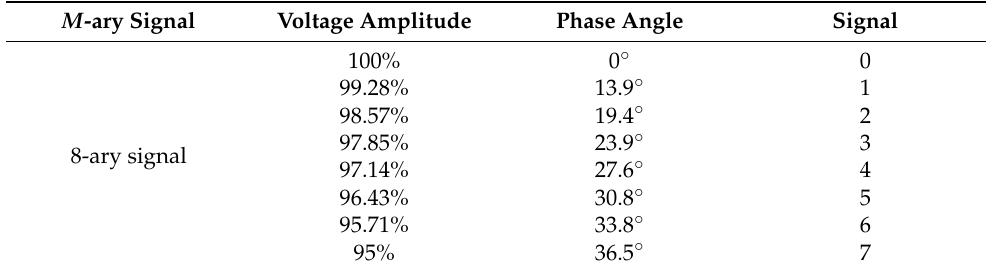
Table 2. Signal modulation